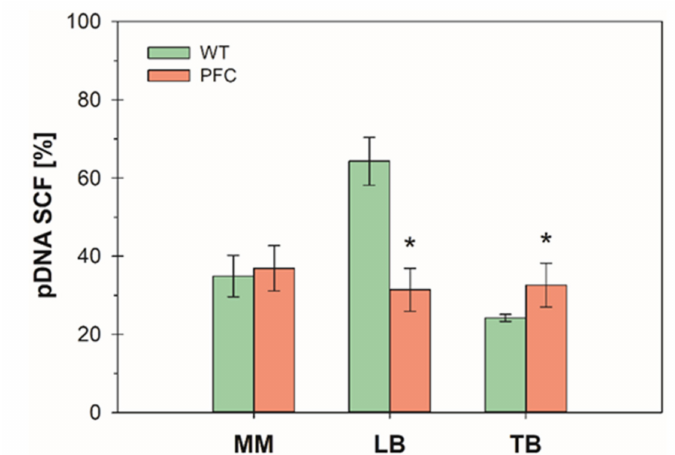
Figure 2. pDNA supercoiled fraction in cultures of the wild type (green bars) and proteome reduced (PFC) (red bars) strains in mineral medium (MM), lysogeny (LB), and terrific (TB) broths. Values correspond to sample taken at the end of the cultures. Error bars show the standard deviation between triplicate experiments. * indicates the groups where significant di ff erence was found ( p <